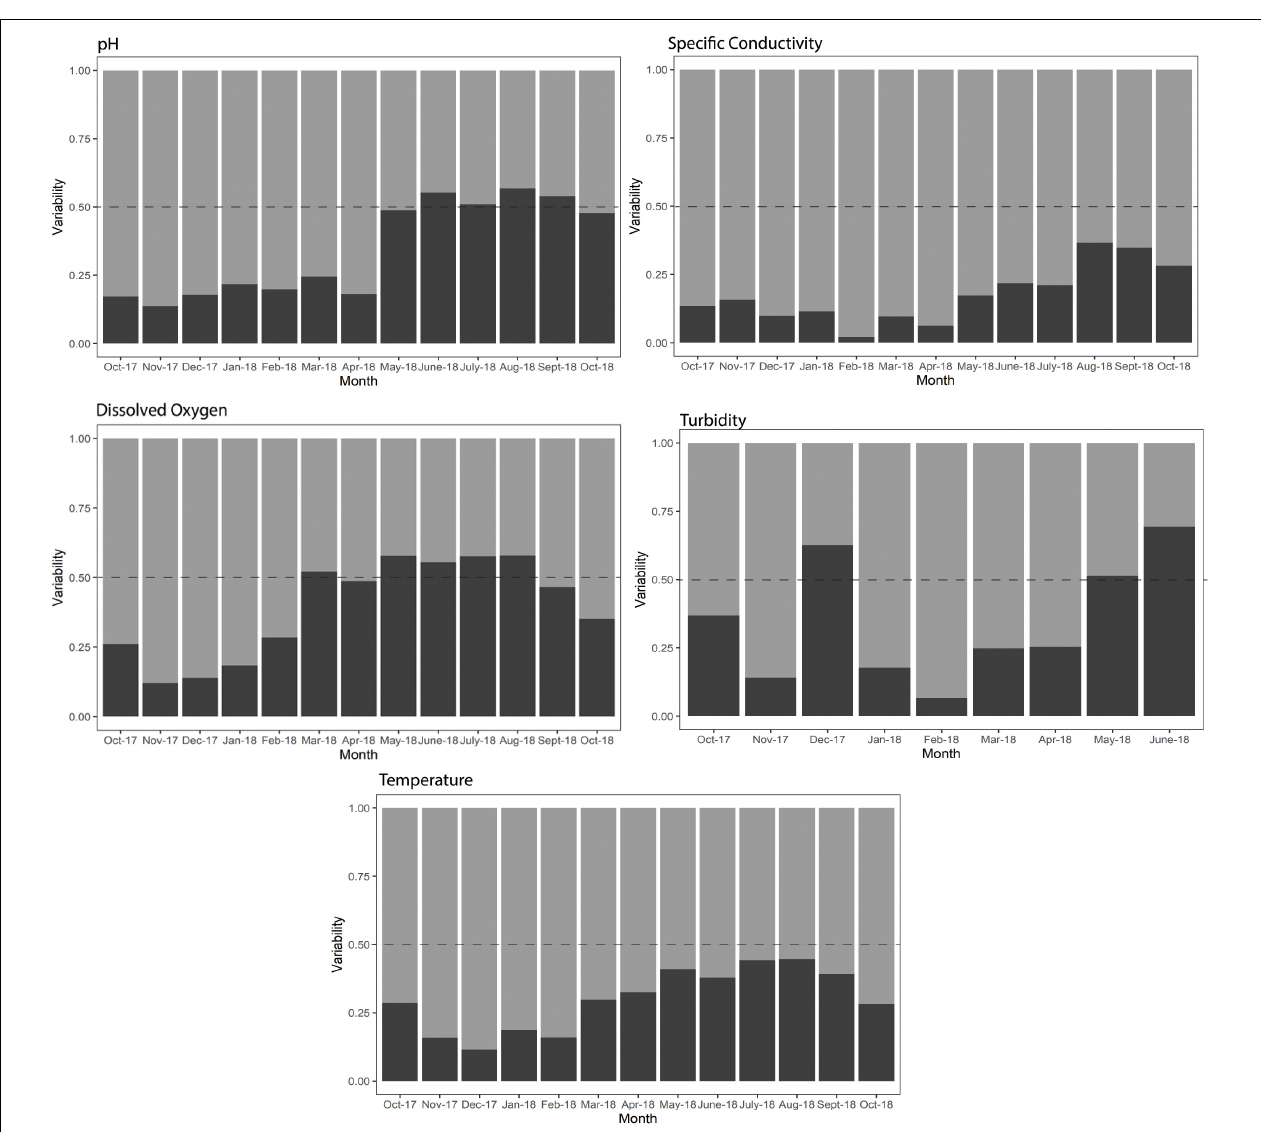
FIGURE 6 | Monthly intercycle (i.e., non-tidal) and intracycle (i.e., tidal) variability for pH, turbidity, dissolved oxygen, specific conductivity, and temperature in the Union River shown as relative proportion for each month. The dashed line indicates a relative proportion of 0.50: i.e., intra-and intercycle variability for that month were equal. Intracycle variability >0.5 (above the dashed line) indicates that tidal variability was dominant, whereas intracycle variability <0.5 (below the dashed line) indicates that non-tidal variability was dominant. Intracycle variability is calculated as the monthly average of tidal cycle standard deviations for each parameter. Intercycle variability is calculated as the monthly standard deviation of tidal cycle